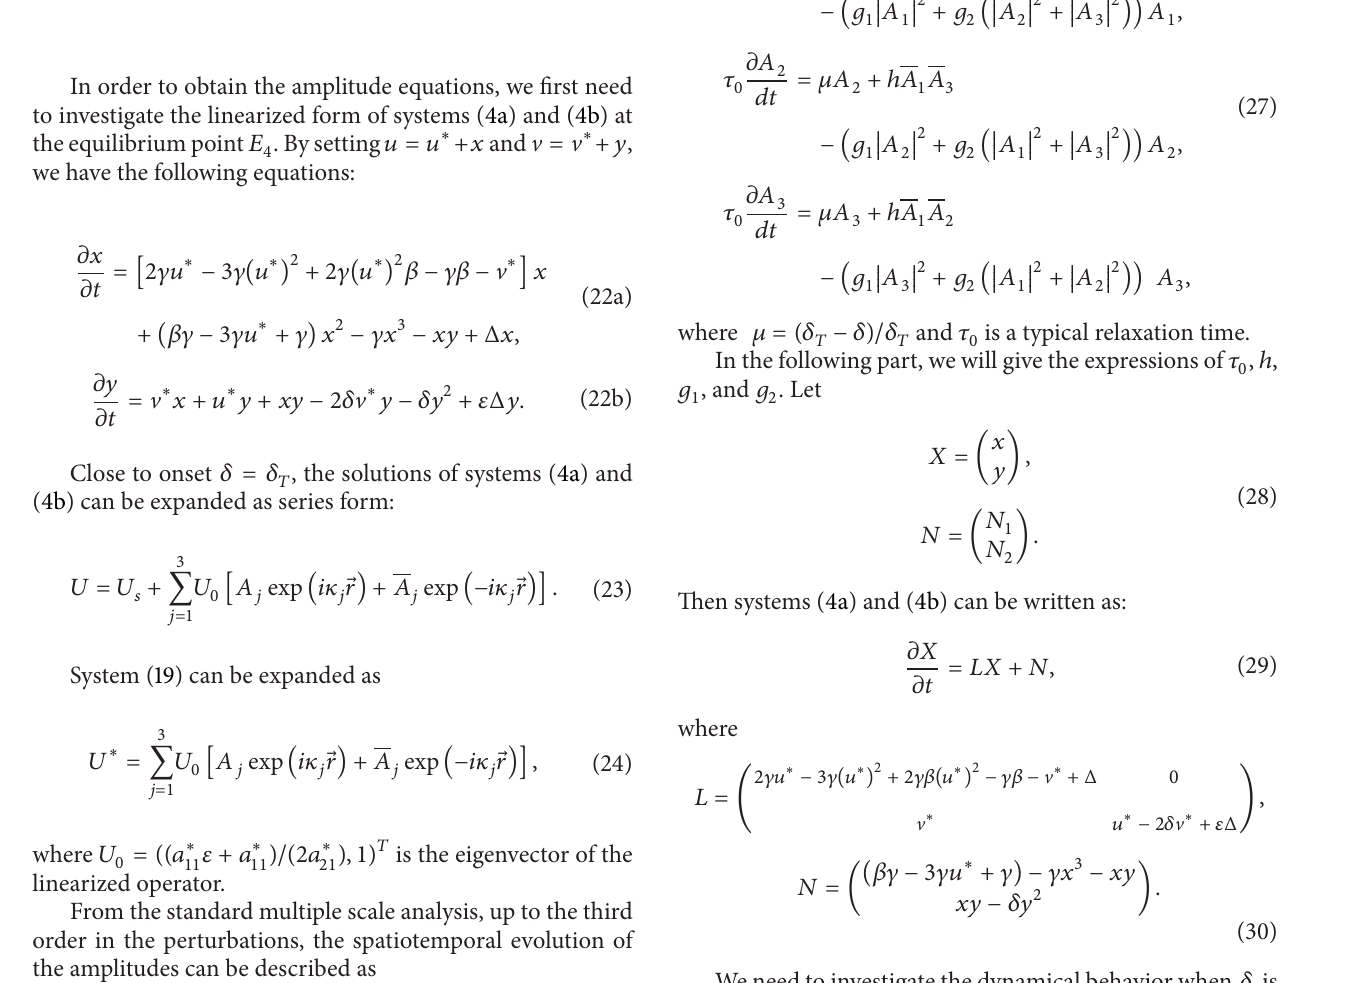
Figure 2: Dispersion relation for different 𝛿 . Parameters values: 𝛽 = 0.02 , 𝛾 = 1.5 , and 𝜀 = 0.15 . (a) 𝛿 = 1.08 ; (b) 𝛿 = 1.04 ; (c) 𝛿 = 1 ; (d) 𝛿 = 0.96 ; and (e) 𝛿 = 0.92